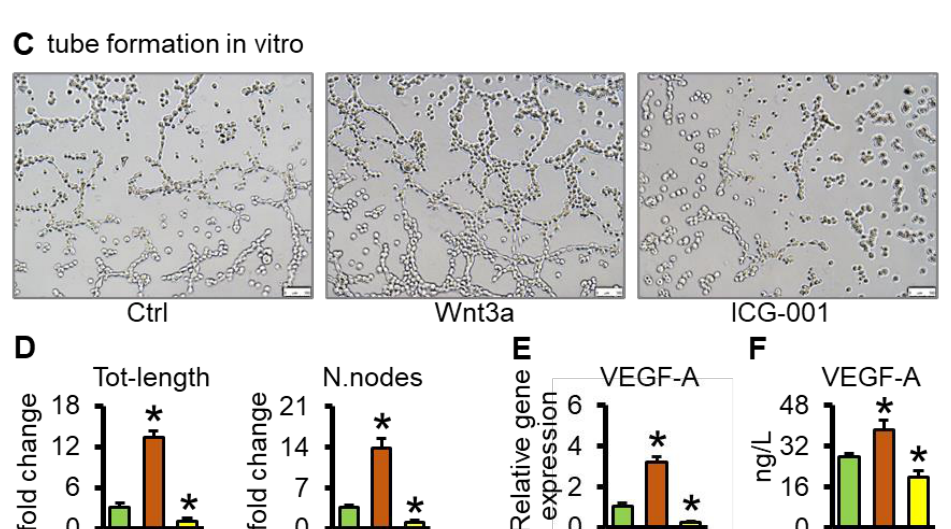
Figure 7. Wnt3a pretreated ST2/GelMA/PCL scaffolds promote vessel formation. ( A ) H&E staining to detect vessel morphology (black dashed area), and blue arrows (red blood cells). ( B ) Quantitative analysis of the number of vessels per unit area (N. Vessel/mm 2 ) (n = 5). In vitro tubule formation experiments, the culture supernatant of the scaffolds was co-cultured with human umbilical vein endothelial cells (HUVECs) on the matrix for 6 h. ( C ) Optical images and ( D ) quantitative analysis of the total length of tubes and the number of tubes in each field (n = 3). The amount of VEGF-A in the cells ( E ) and conditioned medium ( F ) of the ST2/GelMA/PCL scaffolds, (n = 3). Compared with ctrl group, * p < 0.05 by one-way ANOVA. (Scale bars: A, 20 µm, C, 100 µm).